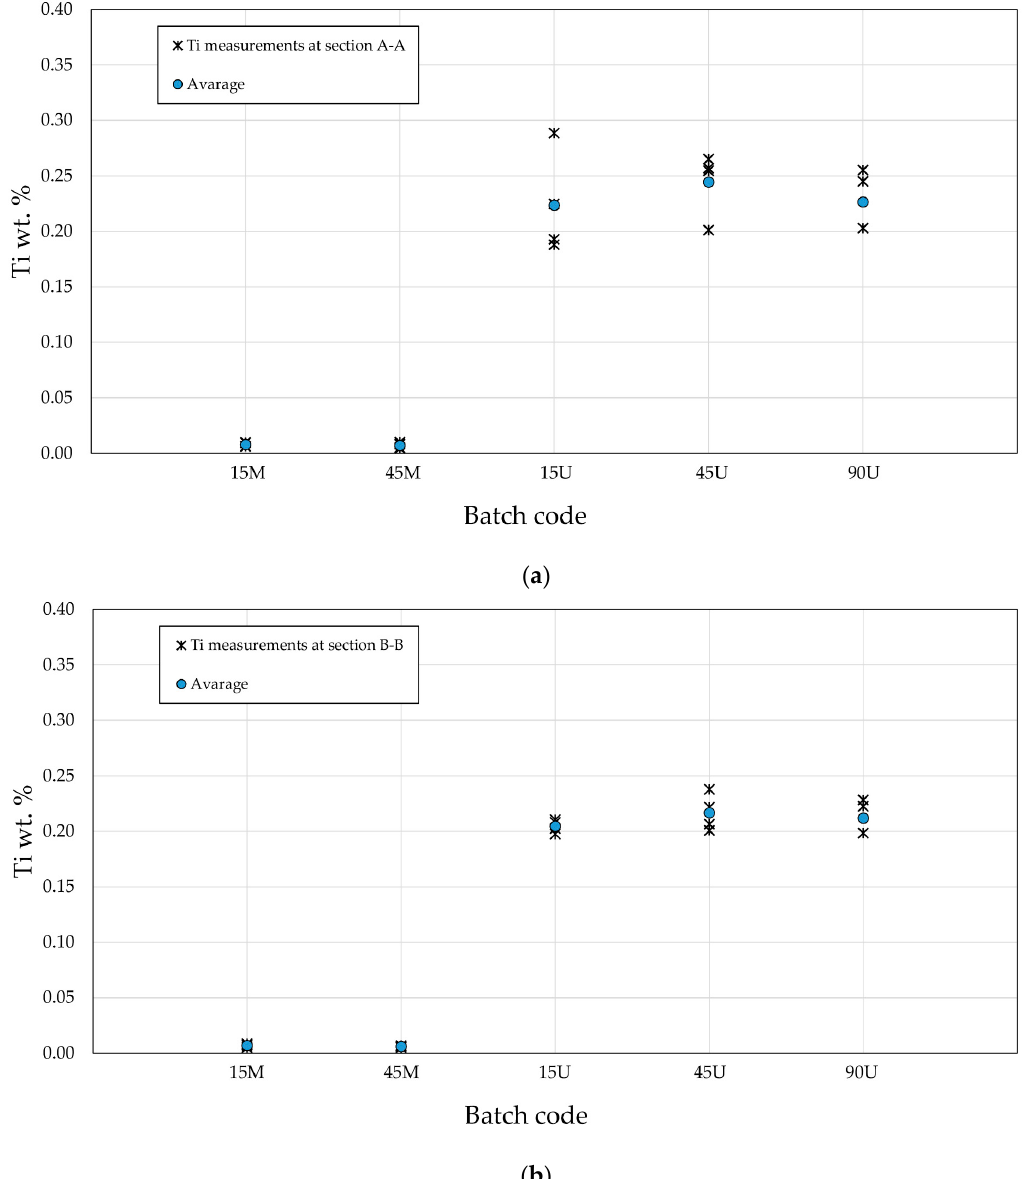
Figure 16. Ti content in the produced alloys ( a ) at section A–A at the middle of the samples and ( b ) at section B–B.